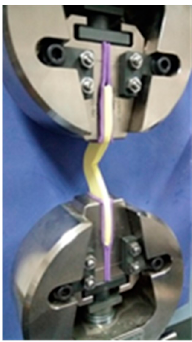
Figure 3. Alginate specimen in Universal Testing Machine.